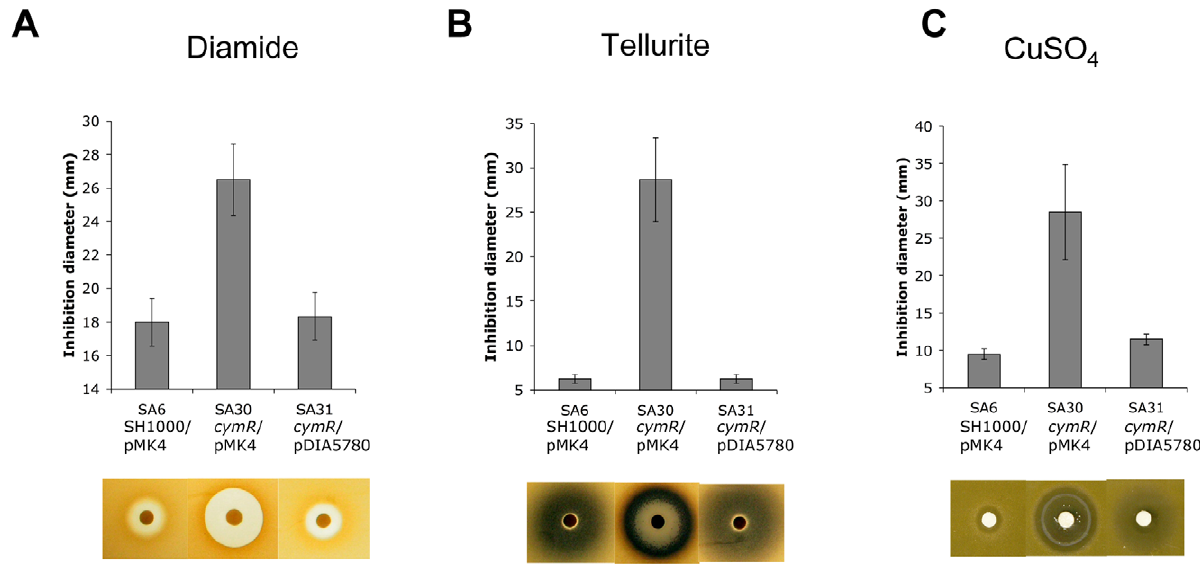
Figure 1. Stress resistance phenotypes of a S.aureus D cymR mutant. Disk diffusion assays were performed with 1 M diamide ( A ), 200 mM tellurite K 2 TeO 3 ( B ) or 200 mM CuSO 4 ( C ) in TSB medium. Quantitative analysis of growth inhibition is shown in the upper panels. The lower section shows representative results of stress sensitivity assays. Strains SA6 (SH1000/pMK4), SA30 ( D cymR /pMK4) and SA31 ( D cymR /pDIA5780) were used for complementation experiments. Results correspond to the mean values with standard deviations and are representative of at least three independent